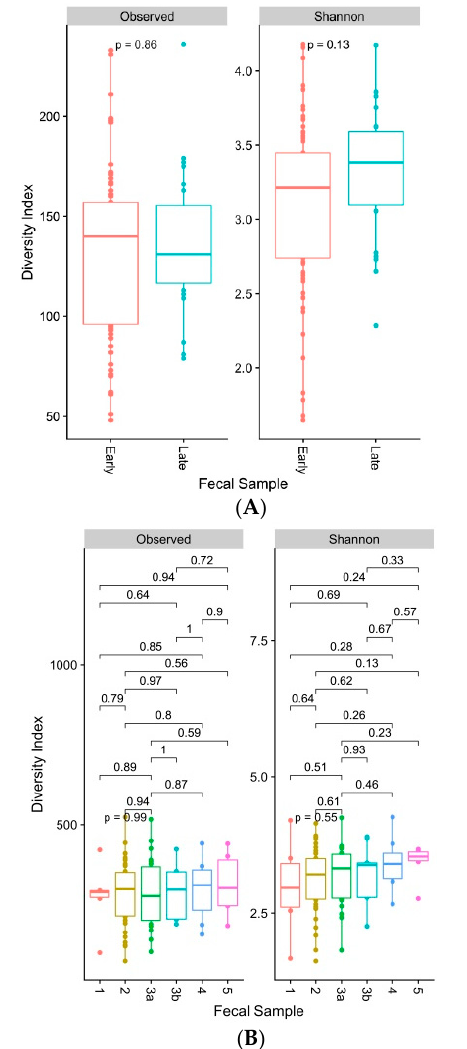
Figure 3. ( A ) . Box and whiskers plots display number of observed bacterial operational taxonomic units (OTUs) and Shannon’s diversity index of faecal samples grouped by individuals with early (1 to 3a) and late (3b to 5) stages of CKD. Boxes represent the interquartile range (IQR) between the first and third quartiles (25th and 75th percentiles, respectively) and the horizontal line inside the box defines the median. Whiskers represent the lowest and highest values within 1.5 times the IQR from the first and third quartiles, respectively. Solid dots ( ● ) outside the whiskers indicate greater than 1.5 times and less than 3 times the IQR. Indices were generated from raw, untrimmed, rarefied data. Significance testing between groups were conducted using a Kruskal-Wallis Test. Results were considered significant where p ≤ 0.05. ( B). Box and whiskers plots display number of observed bacterial operational taxonomic units (OTUs) and Shannon’s diversity index of faecal samples grouped by individuals at CKD stages 1, 2, 3a, 3b, 4, and 5. Boxes represent the interquartile range (IQR) between the first and third quartiles (25th and 75th percentiles, respectively) and the horizontal line inside the box defines the median. Whiskers represent the lowest and highest values within 1.5 times the IQR from the first and third quartiles, respectively. Solid dots ( • ) outside the whiskers indicate greater than 1.5 times and less than 3 times the IQR. Indices were generated from raw, untrimmed, rarefied data. Significance testing between groups were conducted using a Kruskal-Wallis Test. Results were considered to be significant where p ≤ 0.05. The majority (>85% average relative abundance) of bacterial operational taxonomic units (OTUs) identified to the taxonomic level of phylum in the gut microbiome of